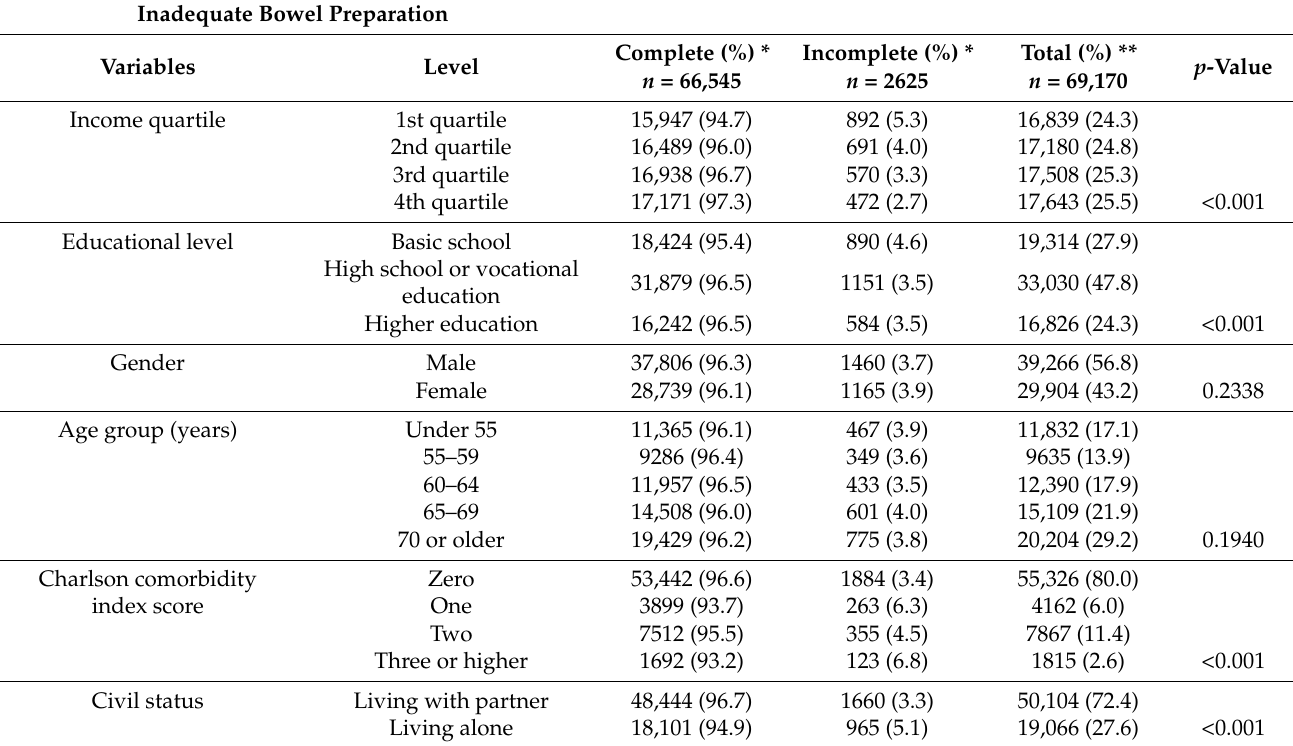
Table 1. Characteristics of the study population stratified by complete colonoscopy or incomplete colonoscopy due to inadequate bowel preparation.